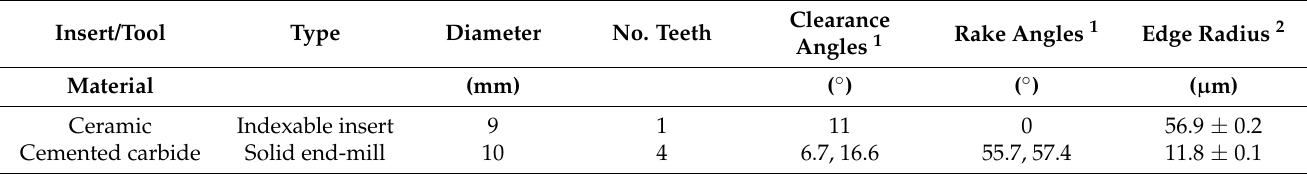
Figure 2. Overview of insert and tools used during the tests where the ( A ) Indexable ceramic insert after cutting tests and ( B ) Solid end-mill tool before the cutting tests. Table 2. Details of the cutting tools used for the tests.